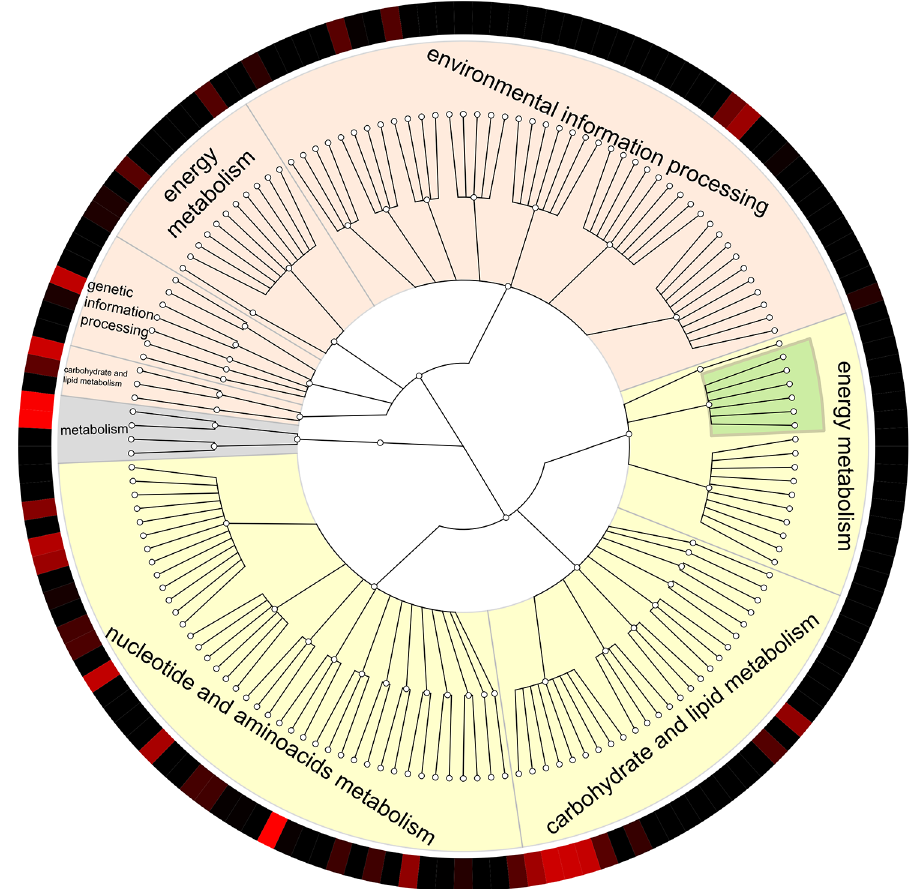
Fig 5. General overview of the functional capabilities of the microbial community in the UASB bioreactor processing acidic effluent from molasses fermentation, drawn with GraPhlAn software (http://huttenhower.sph.harvard.edu/graphlan). Yellow — pathway modules, light orange — structural complexes, grey — functional sets according to KEGG-based classification. Methane metabolism is highlighted in green. The color scale on the outermost ring represents low relative abundance (black) to high relative abundance (red).